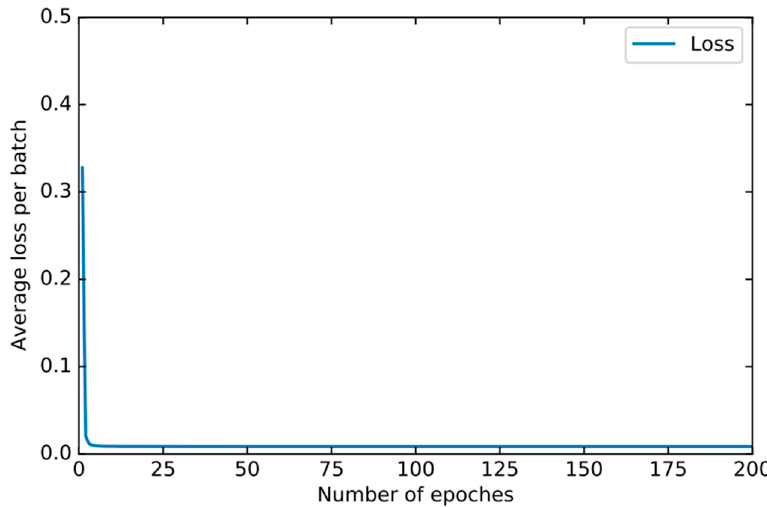
Figure 11. The training loss of DSN changes when different epochs are set.